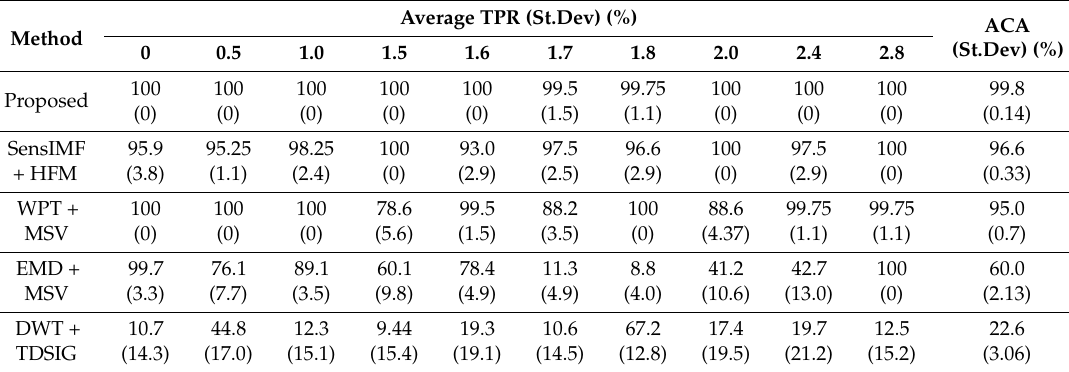
Table 5. Experimental results. TPR, true positive rate; ACA, average classification